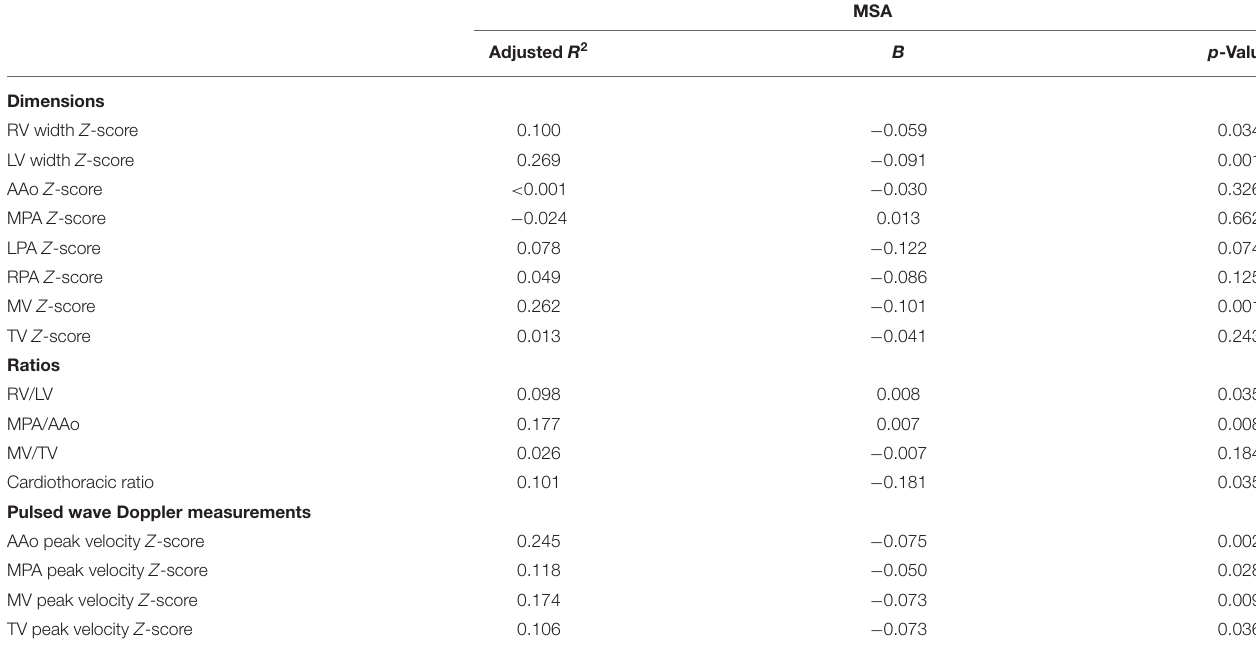
TABLE 5 | Association between MSA value and characteristics Z -score of fetal